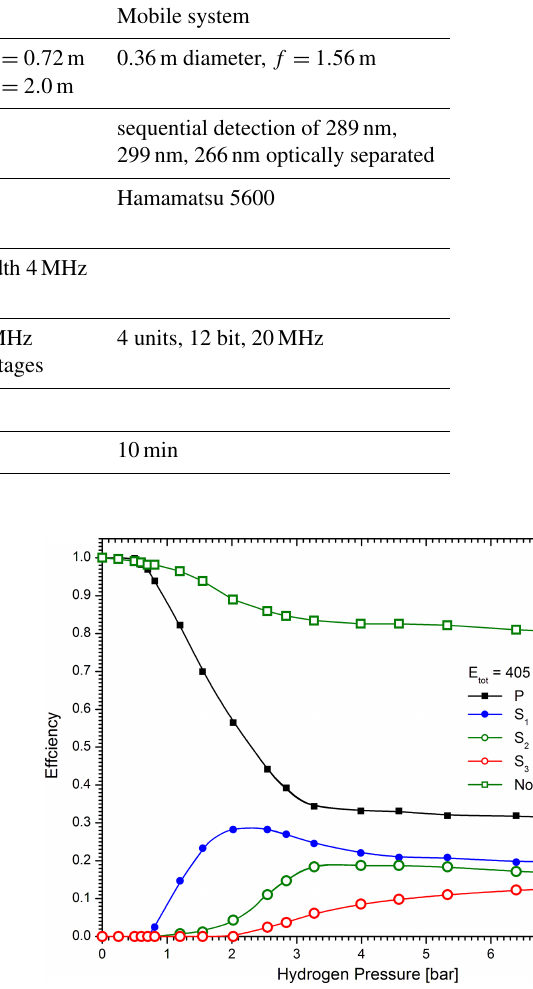
Figure 3. Raman conversion efficiency ( f = 1 . 0m) as a function of pressure for shifting the 248.5nm radiation in hydrogen; the top curve (dark green) represents the sum of the residual pump energy and the first three Stokes emissions normalized to the pump energy at zero pressure. The less important higher Stokes emissions were not measured here but may contribute above 4bar, which would shift the sum to higher